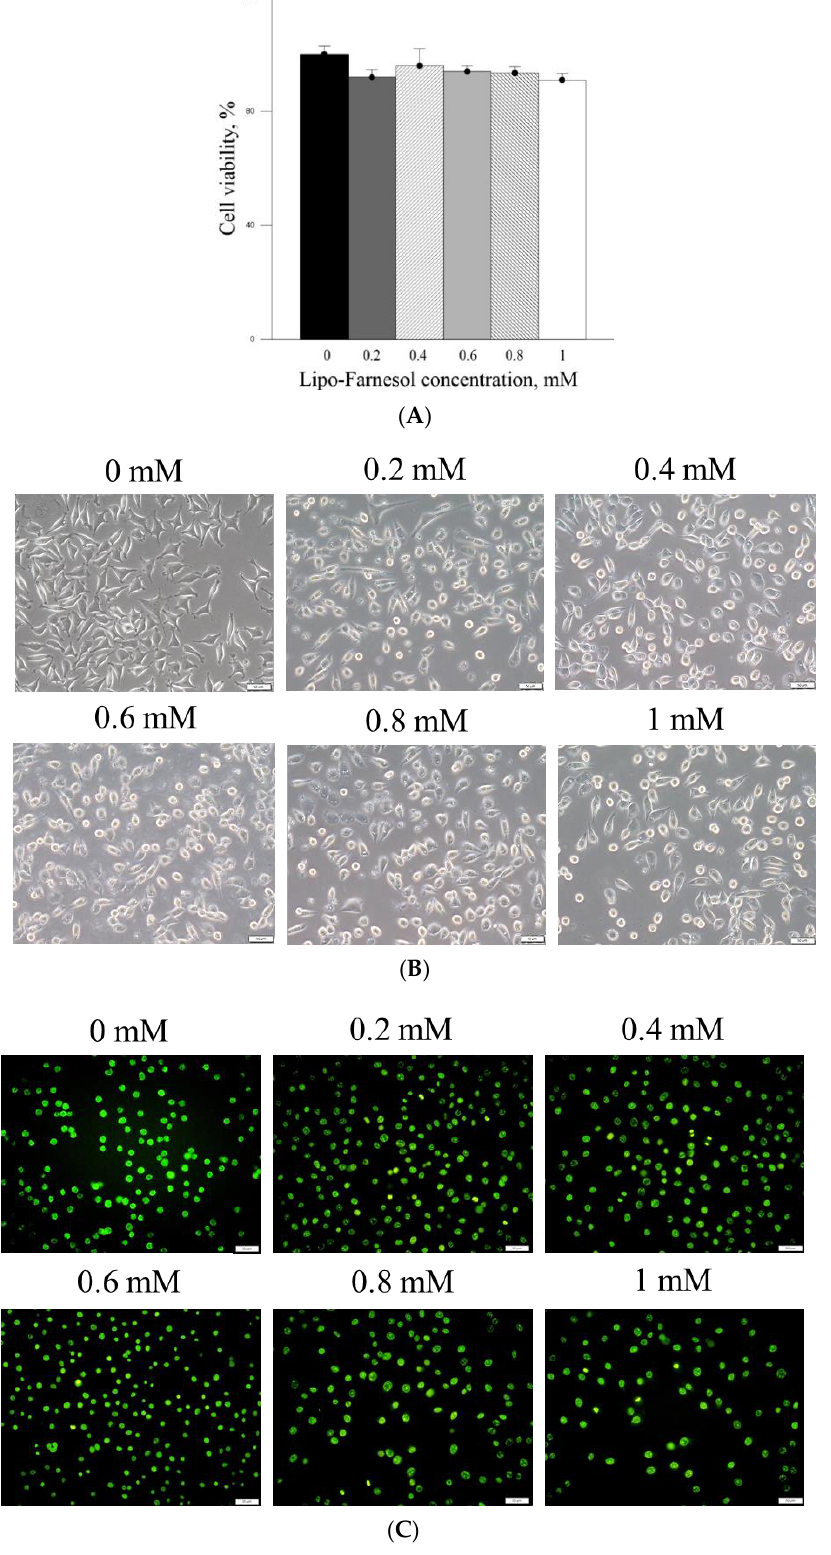
Figure 4. ( A ) MTT cell viability assay of Lipo-Farn in L929 fibroblasts. ( B ) Cell morphology of L929 fibroblasts treated with Lipo-Farn. ( C ) Live – dead staining of L929 fibroblasts treated with different concentrations of Lipo-Farn (green fluorescence, live cells; red fluorescence, dead cells). Bar: 50 μ m.